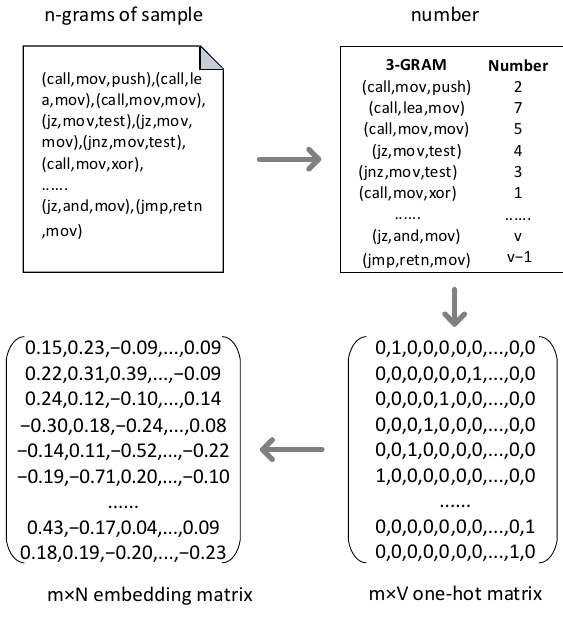
Figure 3. The feature embedding process.